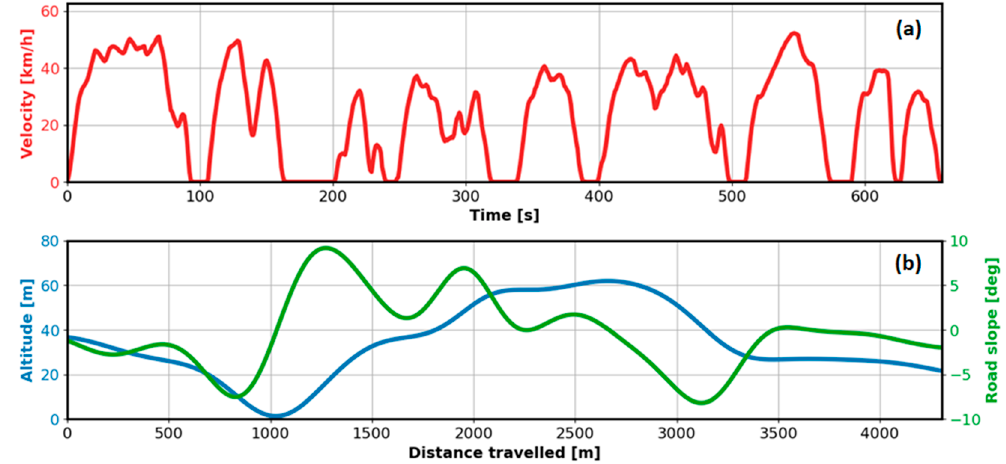
Figure 4. Sample of reconstructed driving cycle for city bus route Hotel Palace–Pile and afternoon hours: velocity vs. time profile ( a ) and road slope vs. distance travelled given along altitude source profile ( b ).